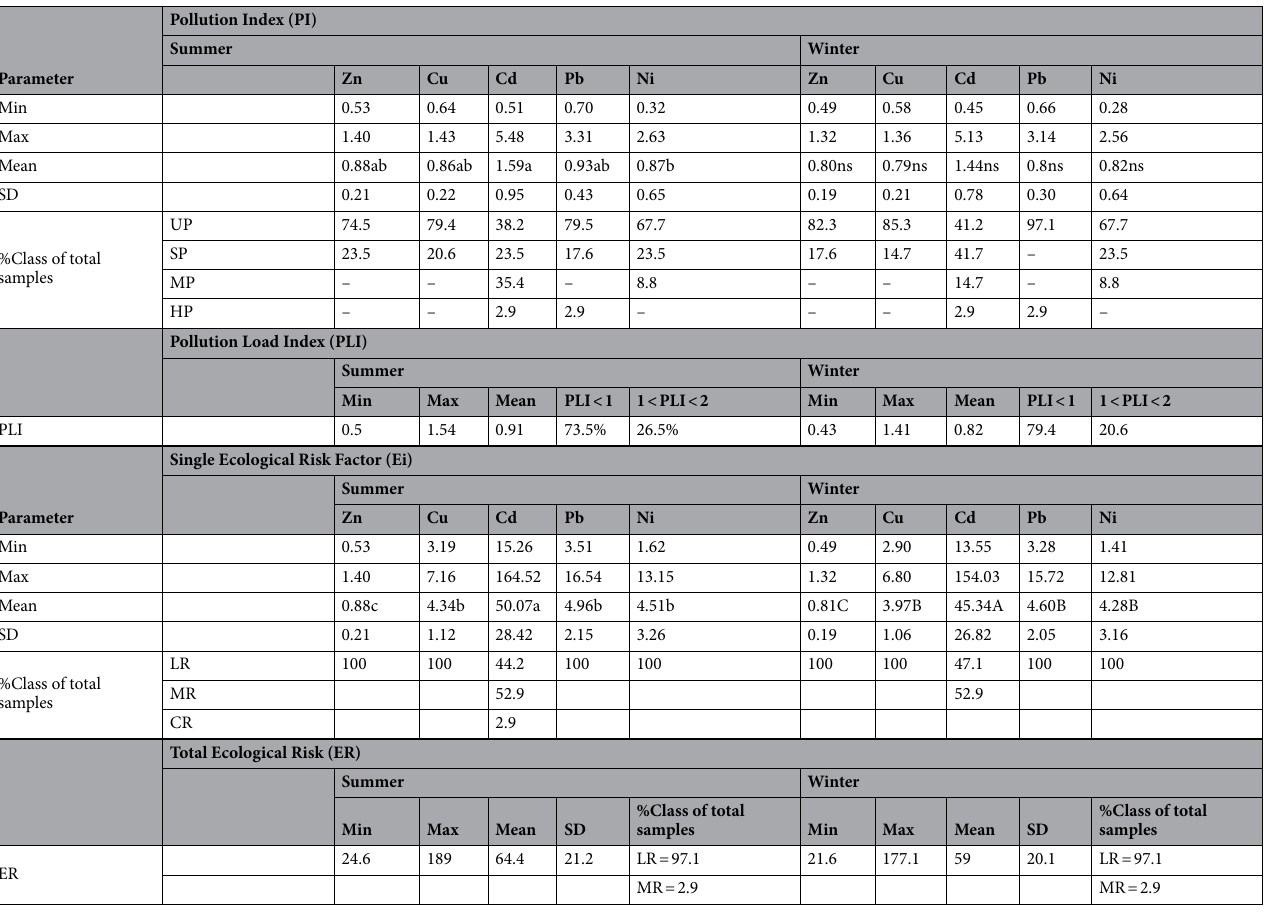
Table 4. The level and categorization of PI, PLI, Ei, and ER of the analyzed heavy metals during summer and winter. PI; UP = Unpolluted (PI < 1), LP = low pollution (1 < PI ≤ 2), MP = Moderate pollution (2 < PI ≤